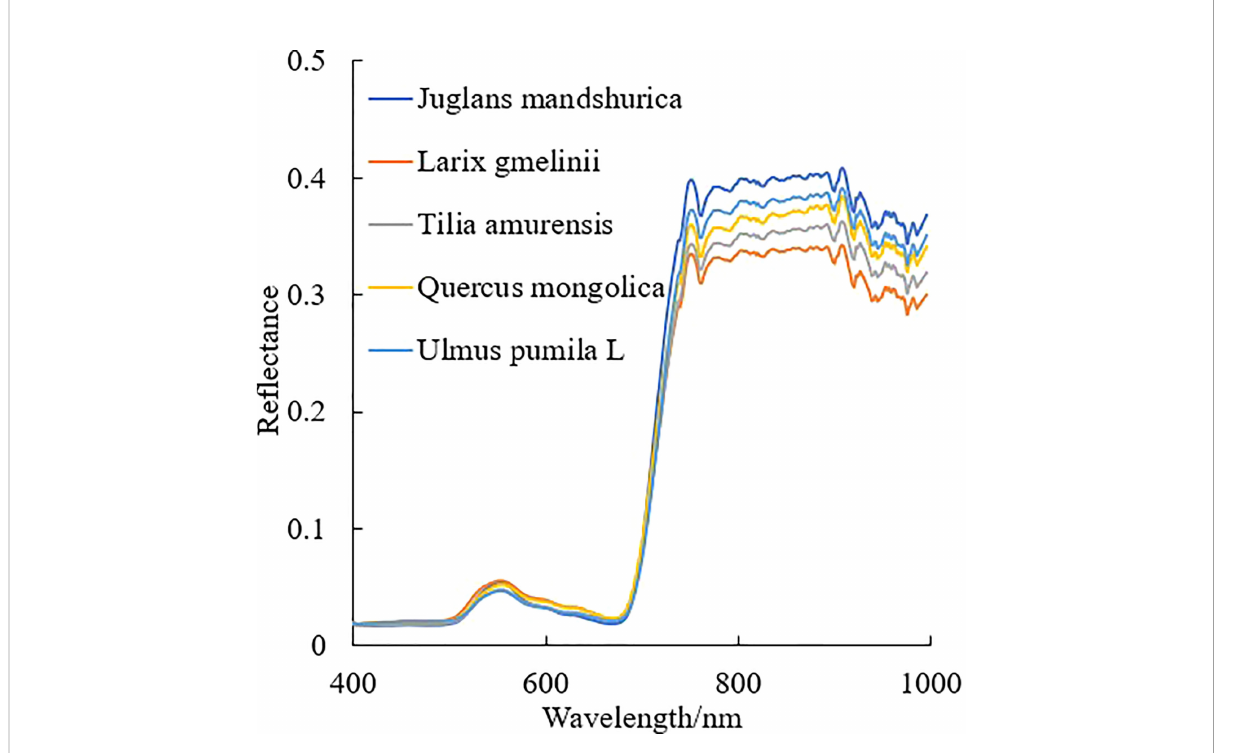
FIGURE 5 Average spectral curves for different tree